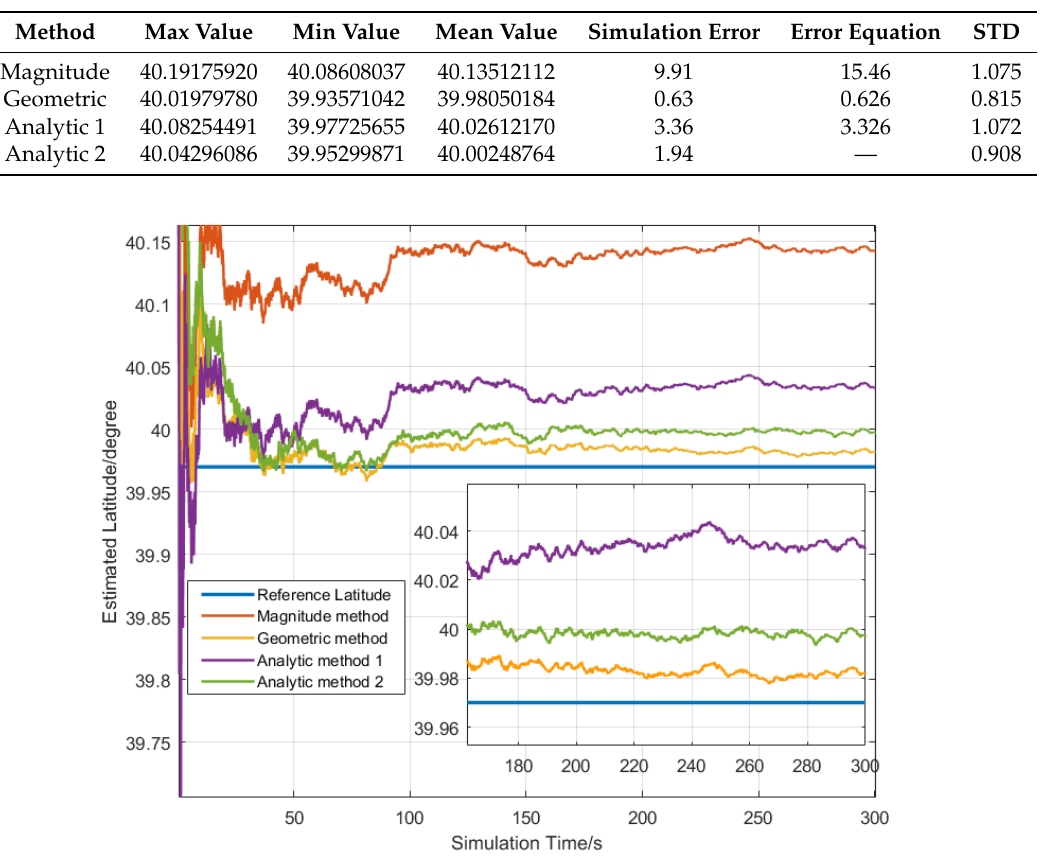
Table 1. The 500 Monte Carlo latitude determination (LD) simulation results of latitude error for navigation-grade inertial navigation system (INS) (the reference latitude is 39.97 ◦ ).